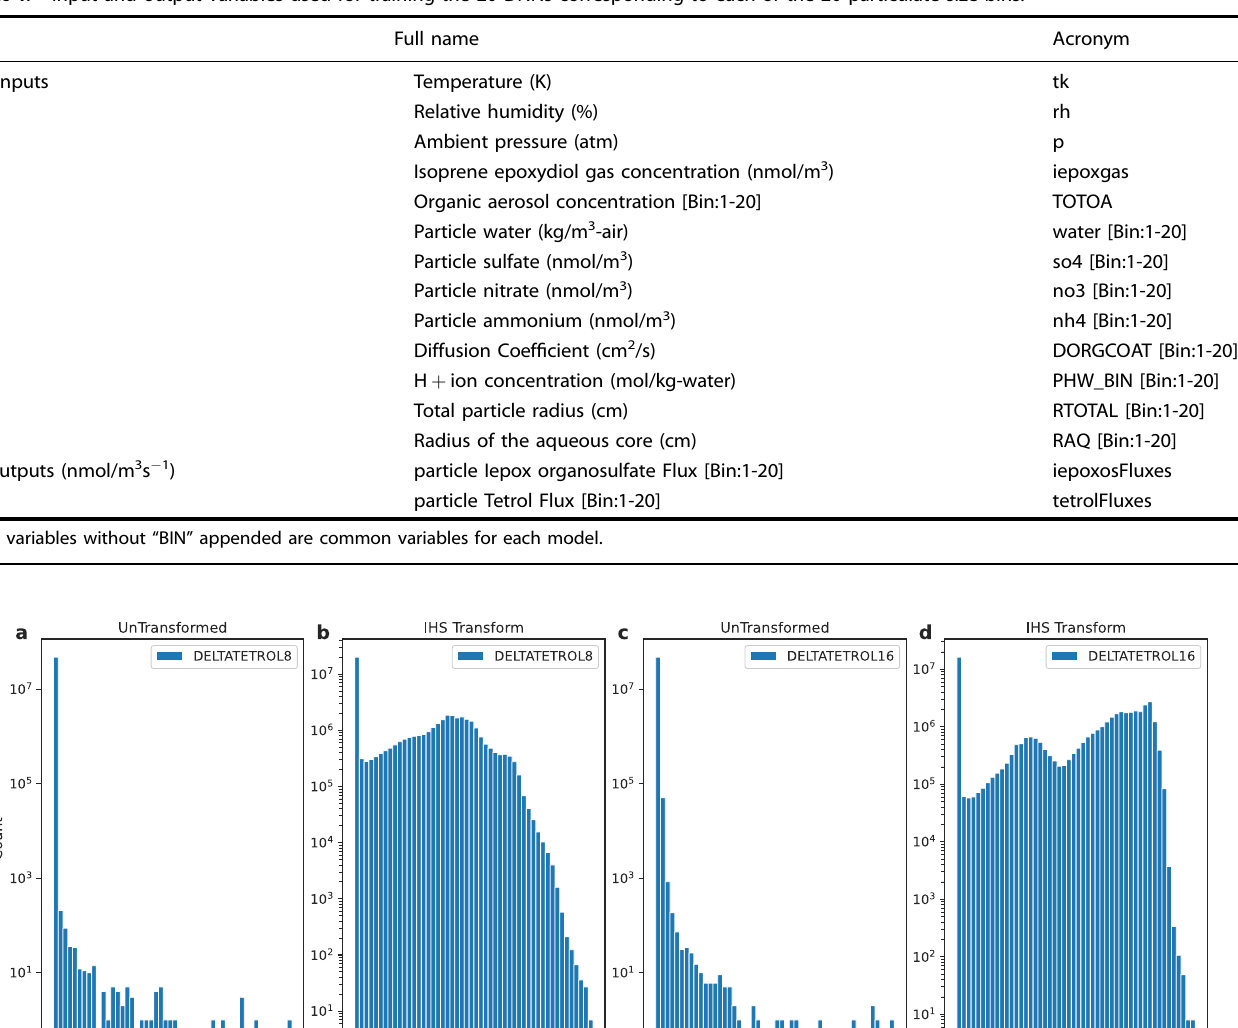
Table 1. Input and output variables used for training the 20 DNNs corresponding to each of the 20 particulate size